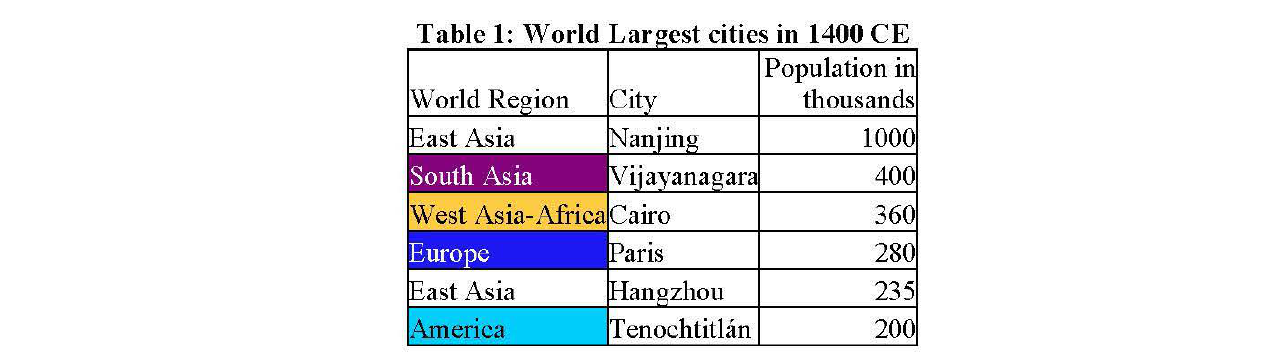
Table 1: World Lar est cities in 1400